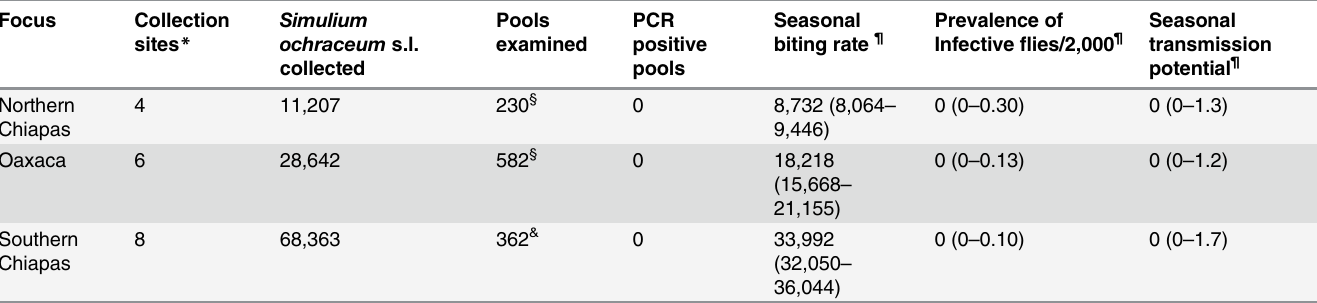
Table 2. Entomological parameters in the three foci of onchocerciasis in